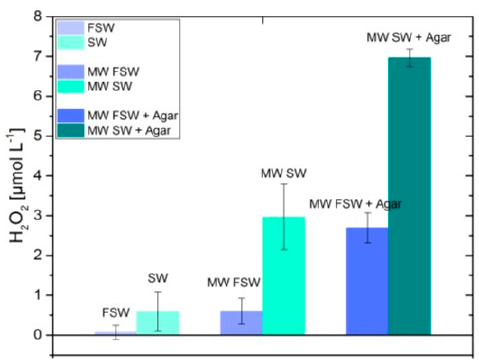
Figure 2. H 2 O 2 measurement of seawater (SW) and filtered seawater (FSW) as well as effects of microwaving SW (MW SW) and FSW (MW FSW) on the H 2 O 2 concentration in solution in the absence and presence of agar (1 wt %). All samples were measured three times ( n =